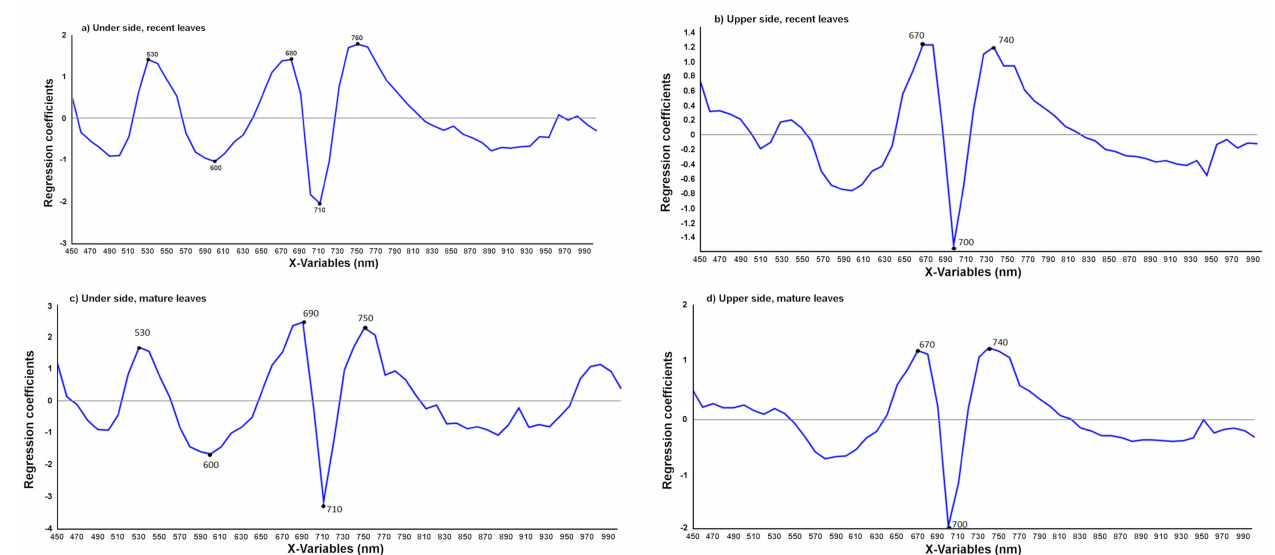
Figure 5. Vector of regression coefficients of the PLS model using mean spectra and with the optimal wavelengths selected at each age and on ( a ) under side, recent leaves; ( b ) upper side recent leaves; ( c ) under side, mature leaves; and ( d ) upper side mature